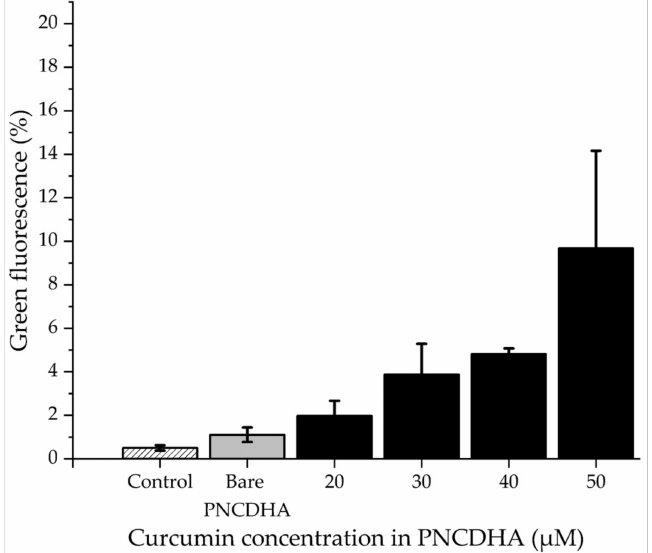
Figure 8. The data from flow cytometry shows percentage of green fluorescence detected in PNCDHA containing various concentrations of curcumin. (Each column represents means. Error bars are standard error of means